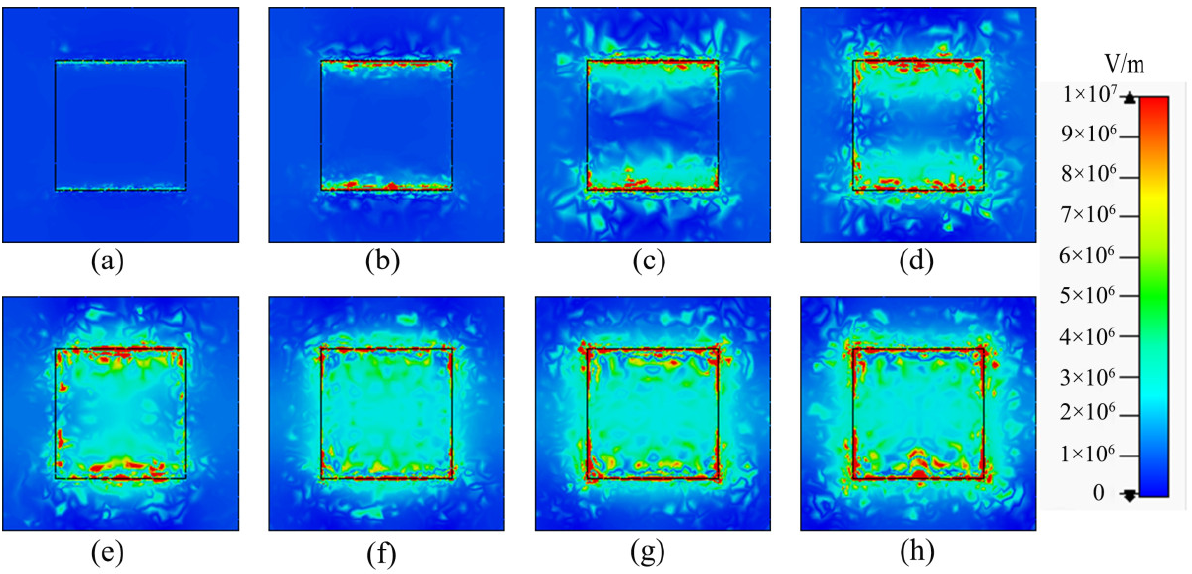
Figure 8. Electric field distributions of the graphene composite layer at the center frequency of 3.970 THz for different Fermi levels of 0–0.7 eV ( a – h ).